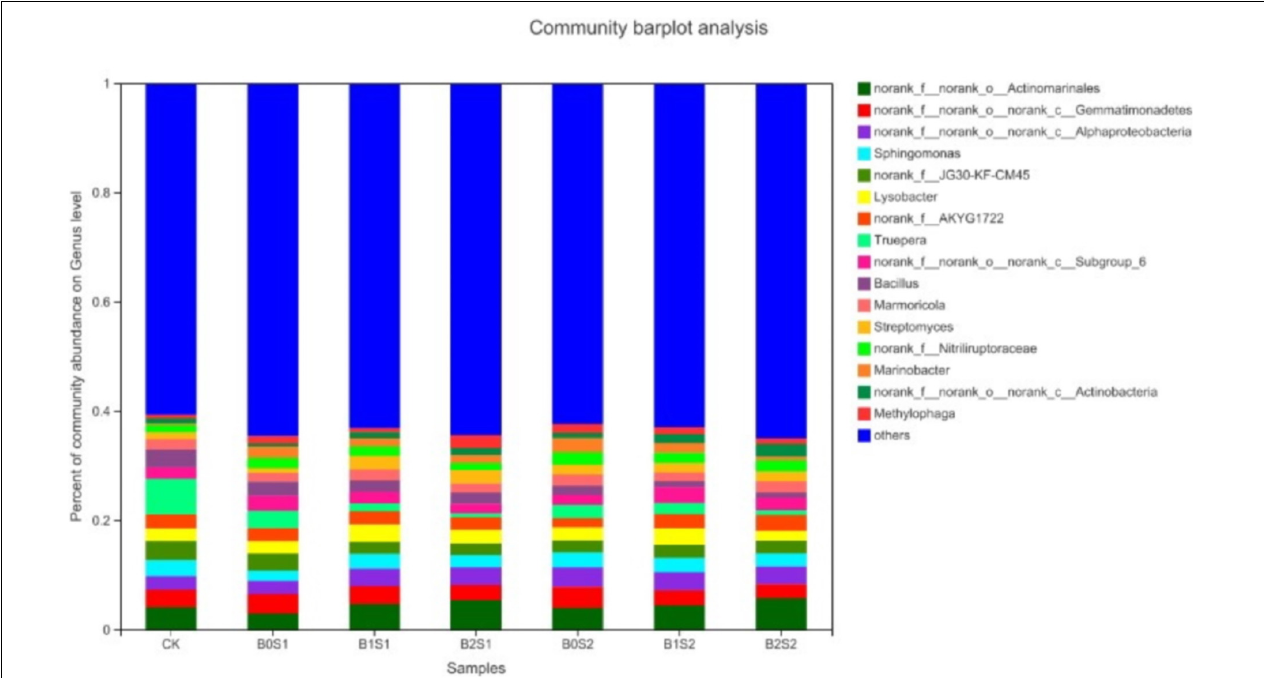
FIGURE 2 | Relative abundance of soil bacterial communities at genus level. Data are presented mean; CK = control, B0S1, B1S1, B2S1, B0S2, B10S2, and B2S2 = 0, 15, and 30 g biochar + 0.5 and 1 g salt g kg − 1